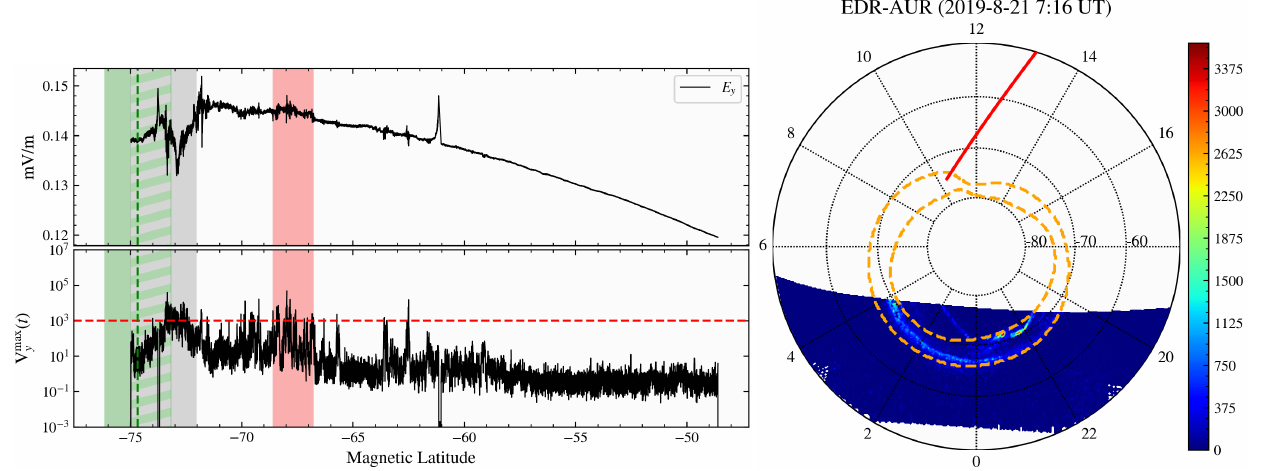
Figure 11. Same as Figure 7, except for orbit 8589. False Positive detection, dayside southern